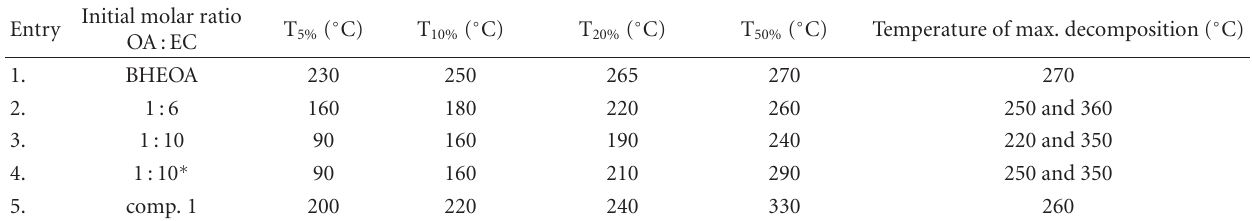
Table 3: Thermal stability of reaction products of BHEOA with EC.